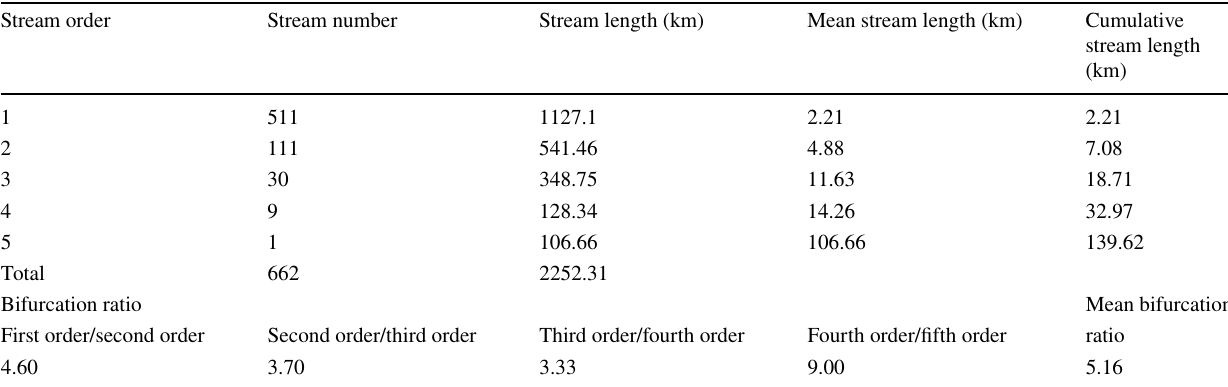
Table 1 Linear aspect of the drainage network of the study area Stream order